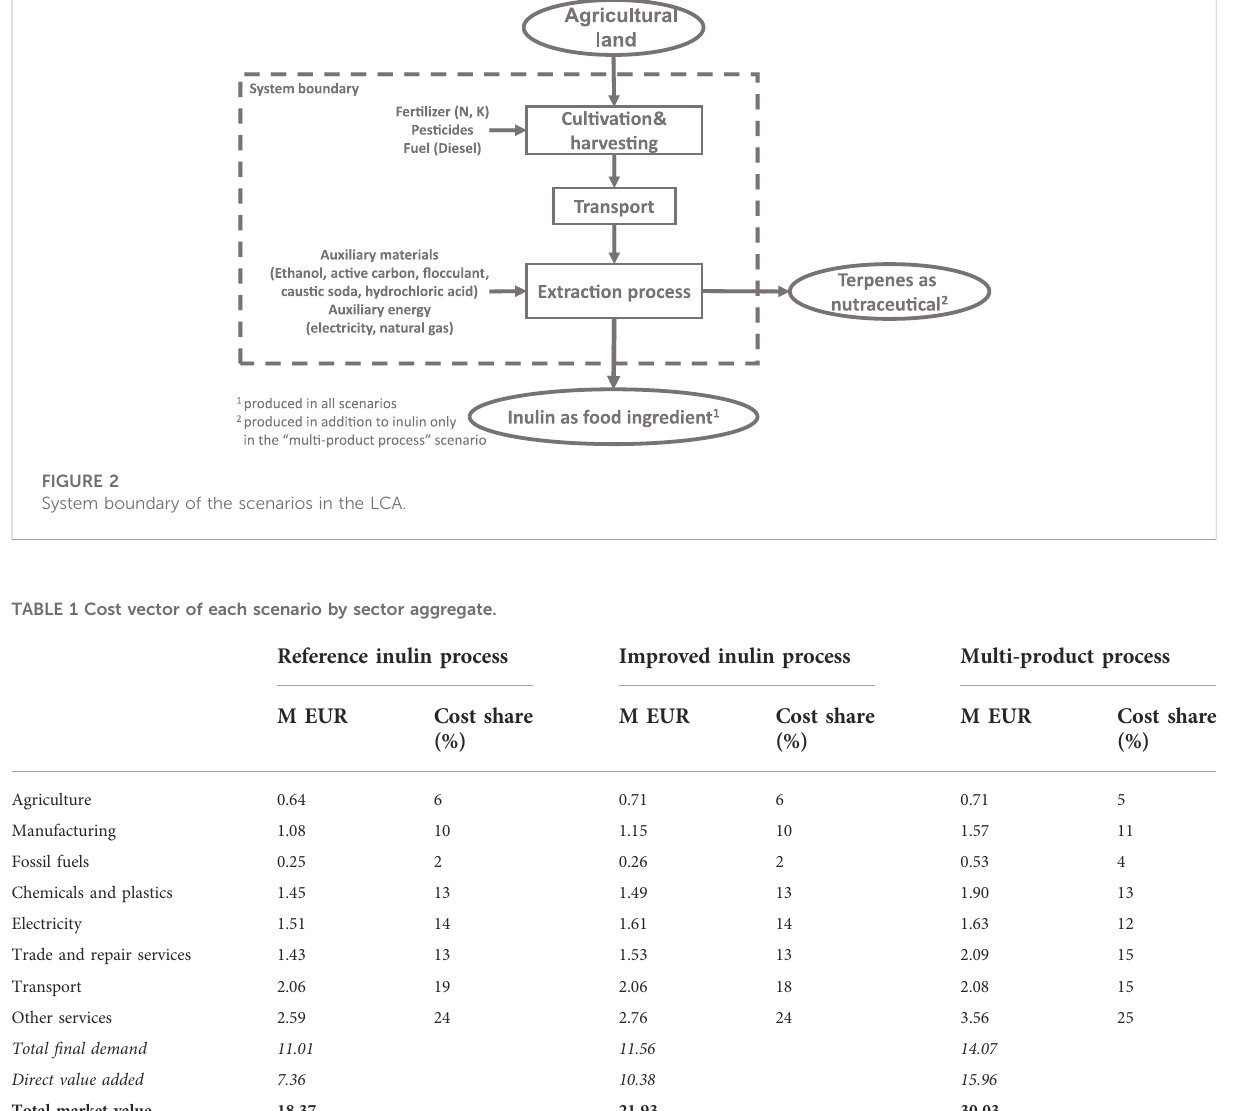
Table SA2). The fi nal demand vector for each scenario